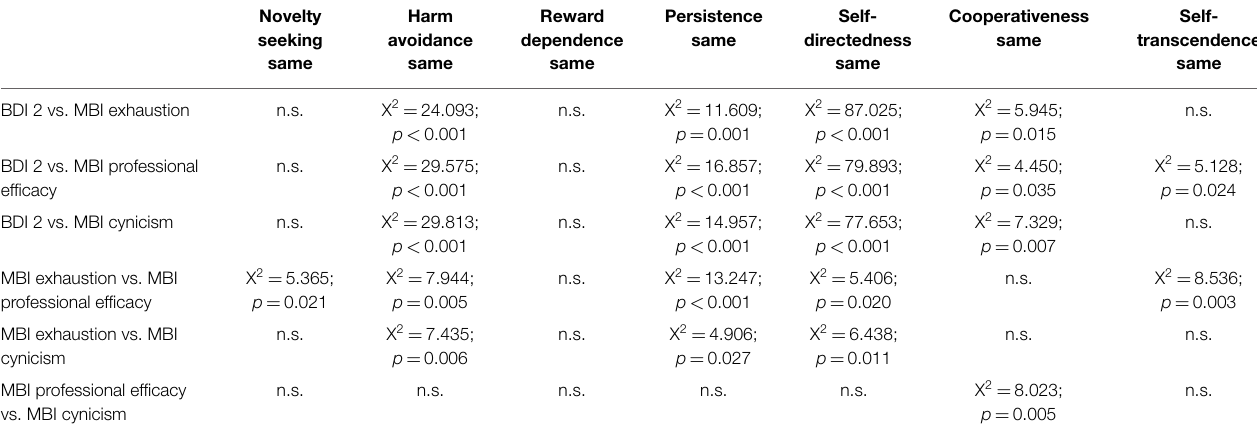
Persistence same